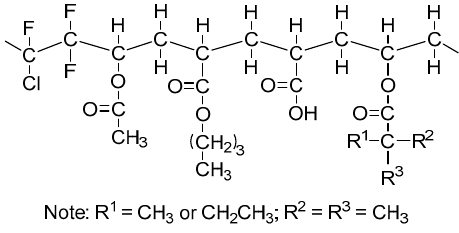
Table 2. Results of the emulsion polymerizations.